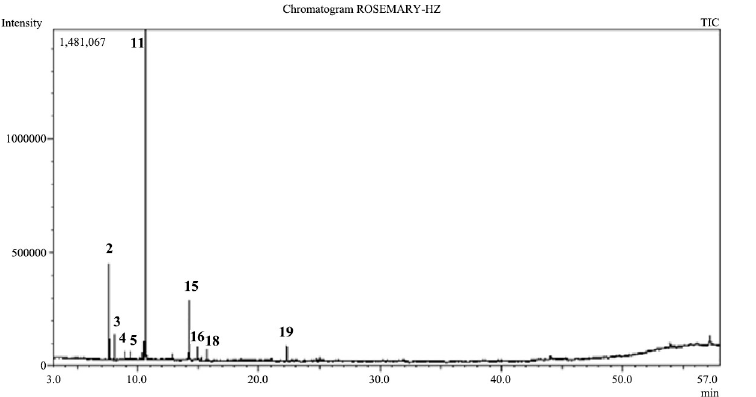
Fig 2. GC/MS chromatogram of the essential oil of Rosmarinus officinalis .